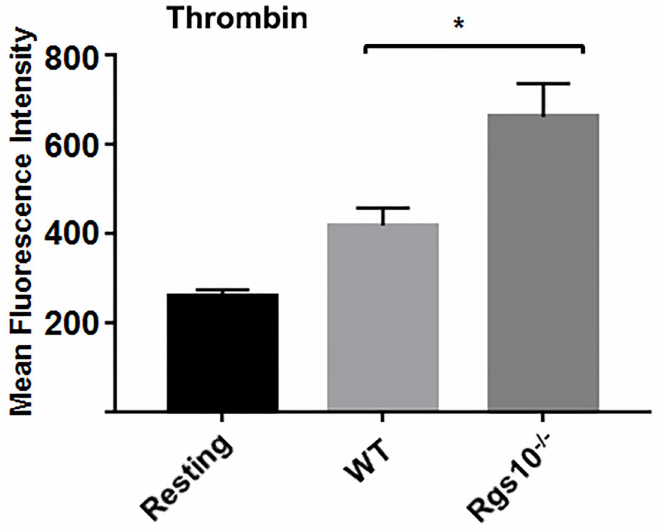
Fig 5. Deletion of RGS10 causes upregulation of α -granule secretion. Platelets from Rgs10 -/- or WT mice (10 5 platelets/100 μ l) were stimulated with 0.1 U/ml thrombin, fixed, and labeledwith CD62P antibody. Samples were analyzedusing a flow cytometer. Average mean fluorescenceintensities shown. Experiment was conducted in duplicate, and repeatedat least 3 times, with blood pooledfrom at least eight mice. (P < 0.05 using Unpairedt